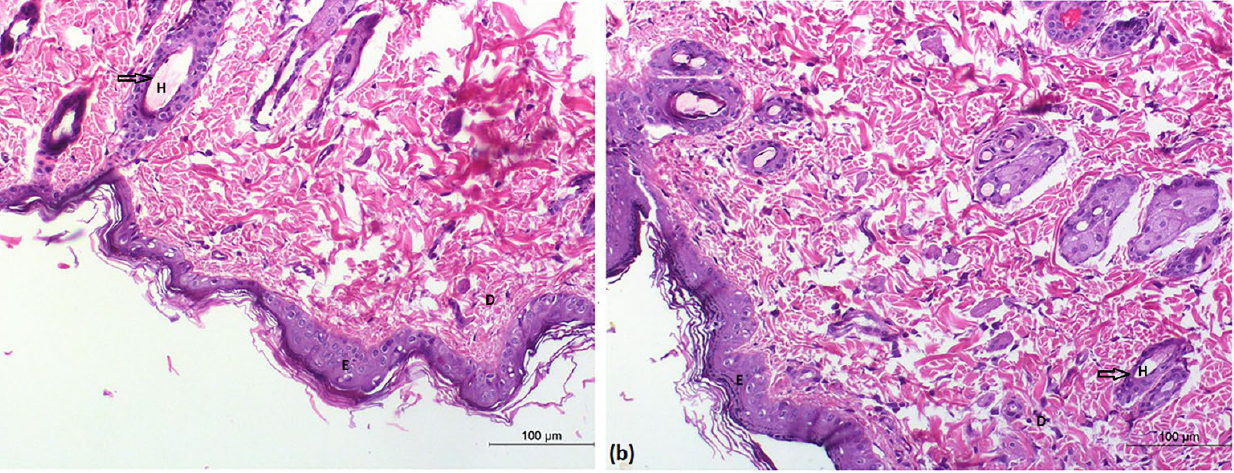
Table 6. Effect of DNa-BSVC gel on % increase paw edema volume measured for 5 h period prior to rats being subjected to carrageenan injection.